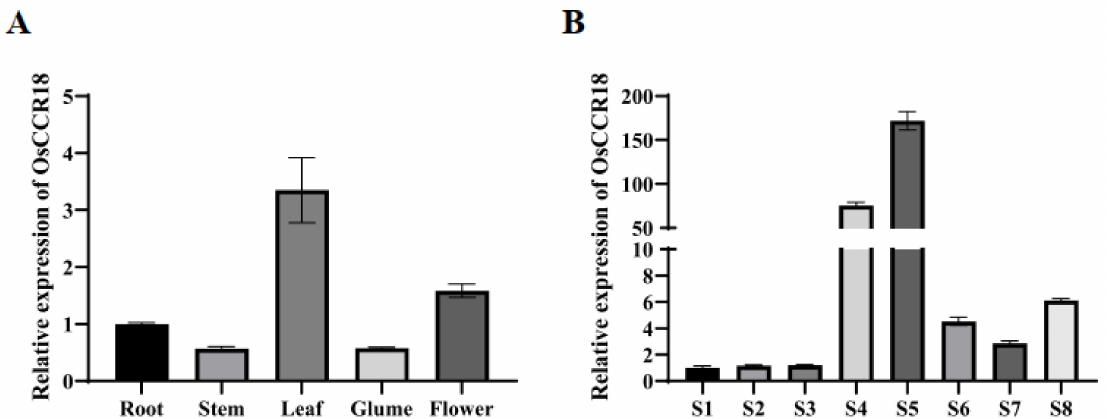
Figure 1. Analysis of the OsCCR18 gene expression pattern in rice. ( A ) Expression pattern analysis of OsCCR18 in roots, stems, and leaves at the seedling stage and in the glume and flower organ at the flowering stage by qRT–PCR. ( B ) Expression pattern analysis of OsCCR18 in anther at different developmental stages by qRT–PCR. Data are shown as the means ± SD ( n =